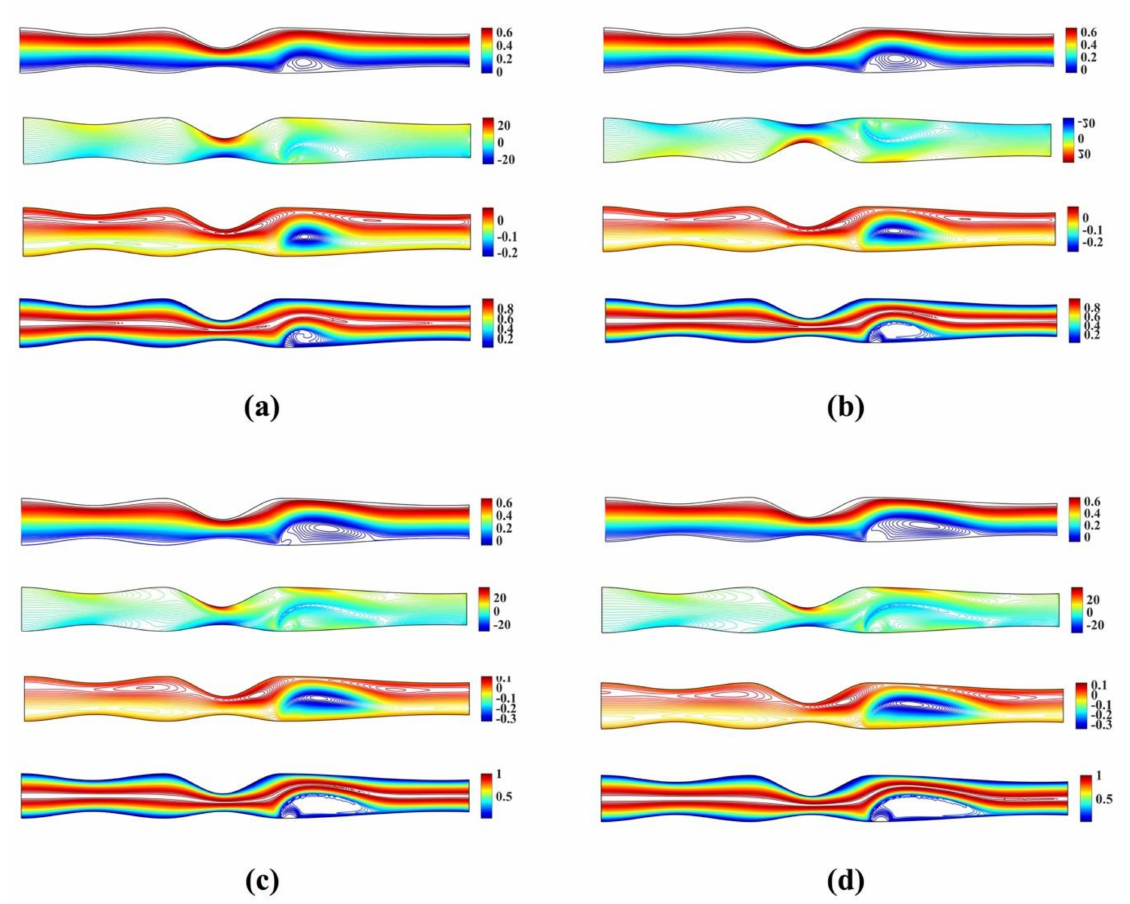
Figure 9. Streamlines, vorticity, microrotation contours and isotherms for the irregular multi stenoses flow case using Mn F = 656, Mn M = 1.2, K = 2 and ( a ) Re = 50 ( b ) Re = 100 ( c ) Re = 200 and ( d ) Re =